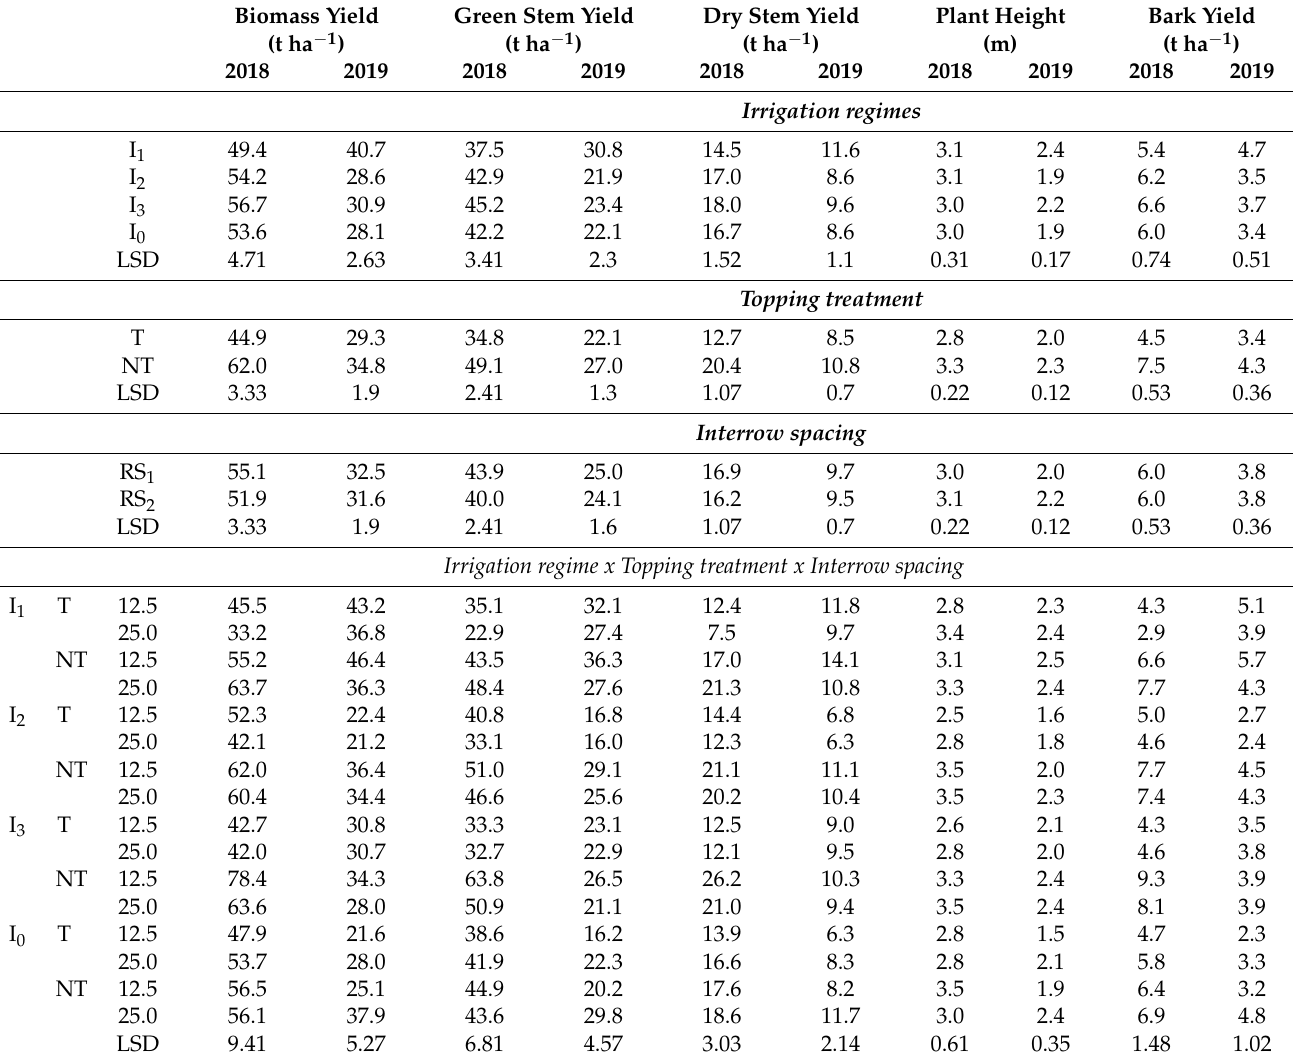
Table 5. Irrigation, topping, and interrow spacing effects on plant height and yield of hemp fiber. Biomass